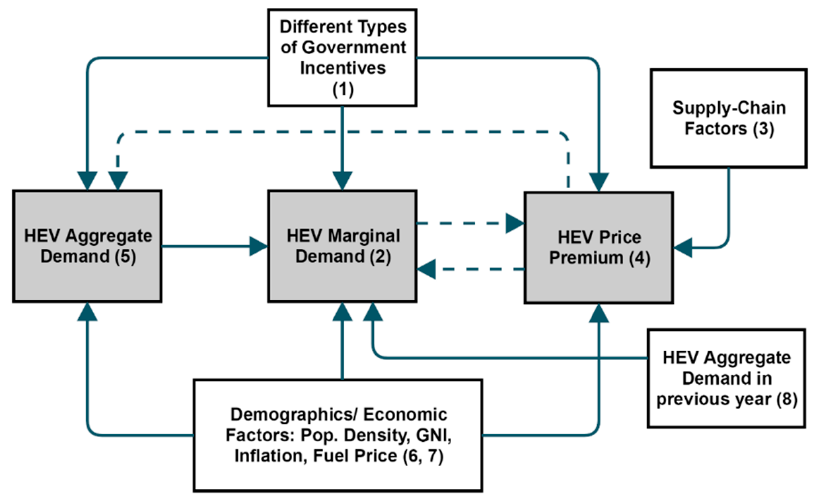
Figure 1. Conceptual Model of Factors Influencing HEV Price Premium, Annual HEV Marginal Demand and Annual HEV Aggregate Demand.